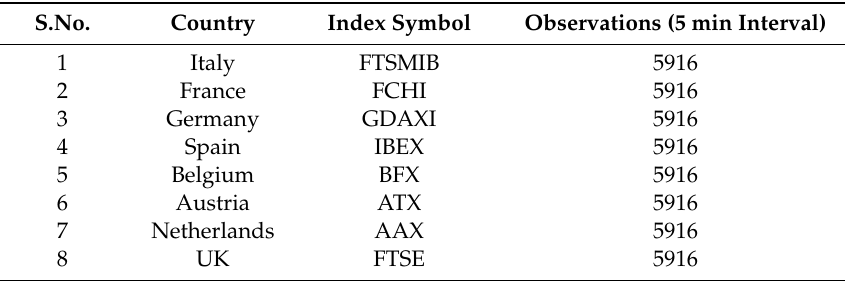
Table 1. List of countries with corresponding stock